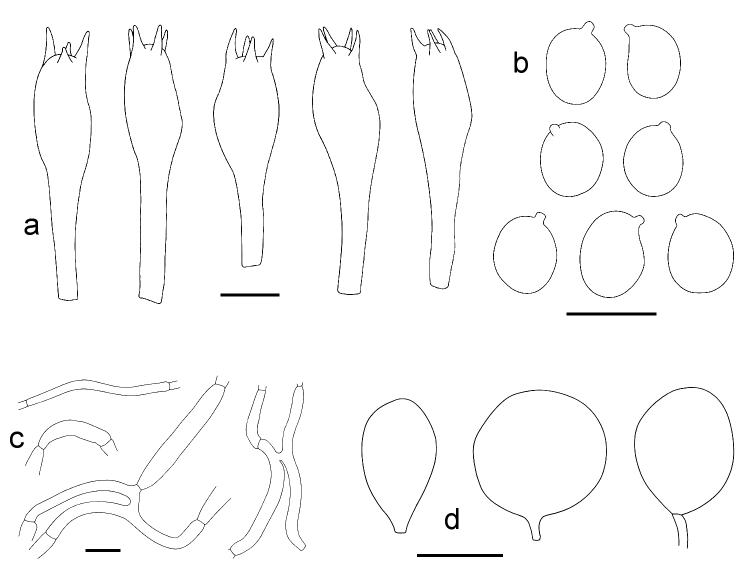
Amanitabweyeyensisa Basidia (from Degreef 1257, scale bar: 10 µm) b Spores (from Saarimäki et al. 591, scale bar: 10 µm) c Filamentous hyphae from the volva (from Degreef 1304, holotypus, scale bar: 20 µm) d Sphaerocysts from the volva (from Degreef 1304, holotypus, scale bar: 50 µm).